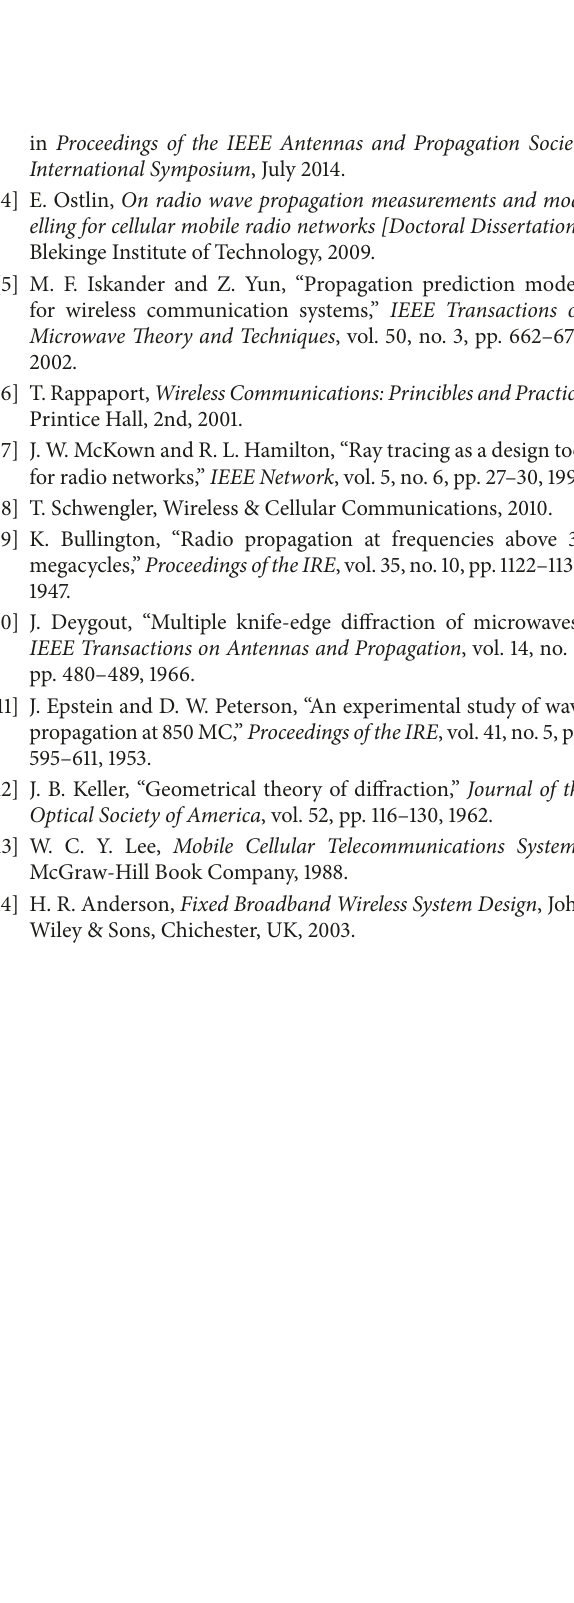
Figure 12: Diffraction losses versus number of obstacles.